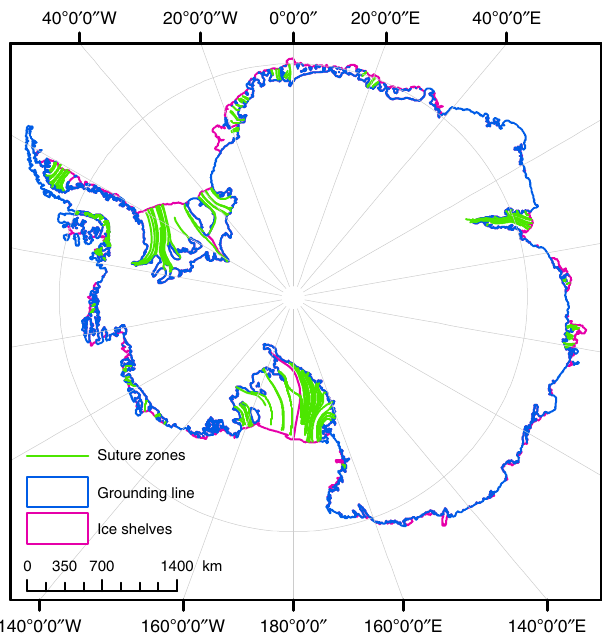
Fig. 1 Principal suture zones on the Antarctic ice shelves. The shelves ’ calving fronts and grounding lines are, respectively, shown in magenta and blue colours 52,60,61 . Suture zones are shown in green and are abundant on all major and most smaller ice shelves.